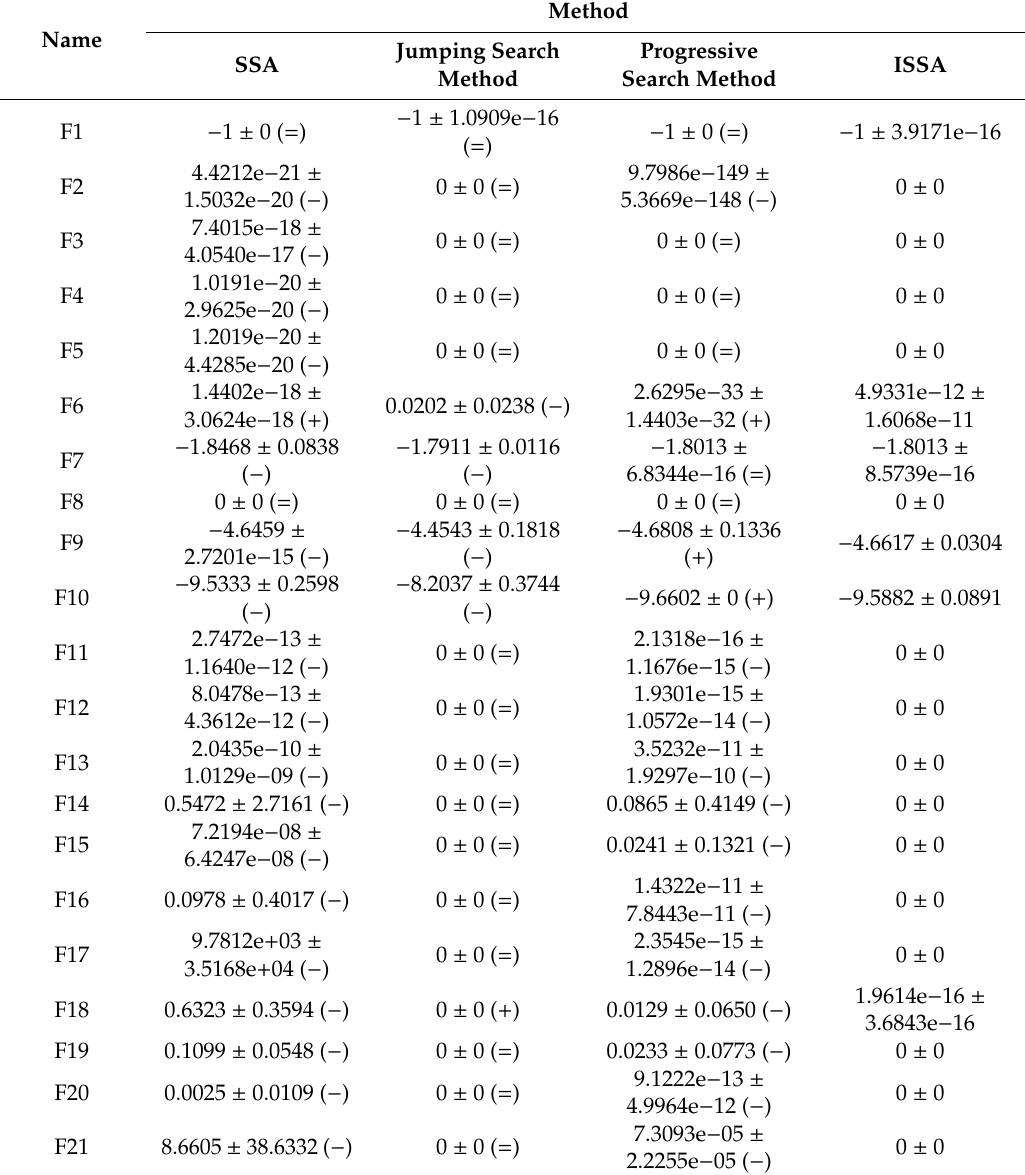
Table 5. The comparison of the convergence